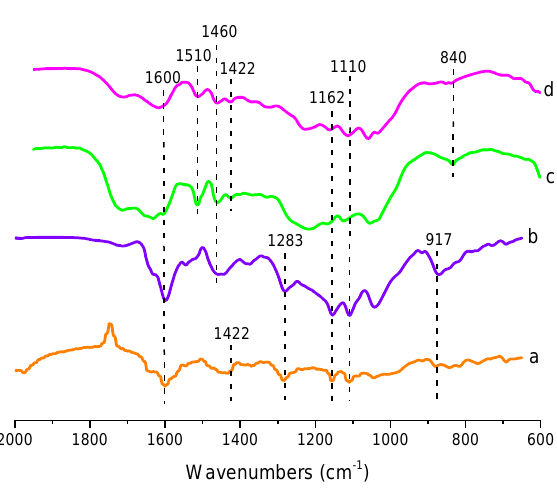
Figure 2. Fourier transform infra-red (FTIR) band from ( a ) LMP, ( b ) LCC, ( c ) LCS, dan ( d ) LMPT. Y-axis is transmittance. Table 1. Peaks Observed in FTIR Spectra